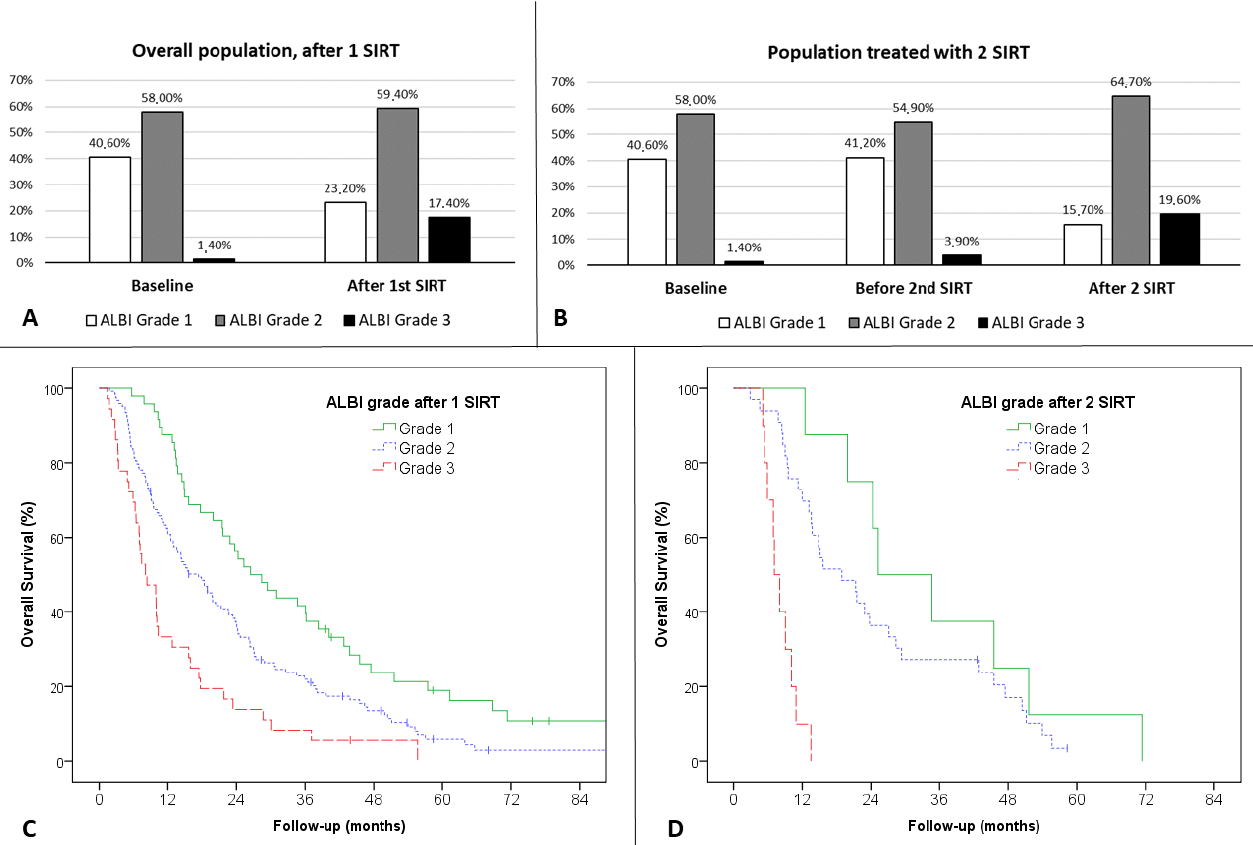
Figure 3. ALBI grade variations after treatment: ( A ) proportion of patients in each ALBI grade, before and after SIRT after 1 SIRT; ( B ) proportion of patients in each ALBI grade, before and after 1 and 2 SIRT, for patients treated with 2 SIRT; ( C ) overall survival according to ALBI grade after first treatment; ( D ) overall survival according to ALBI grade after two treatments.